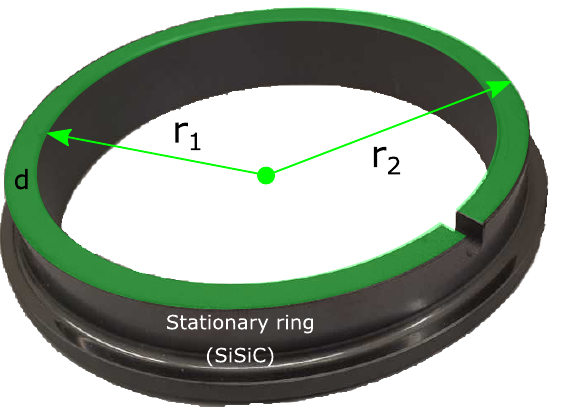
Figure 2. Schematic of the stationary ring used in this study. A transmitter has to be placed on top of the ring and inside the green area. The thickness d is given through the inner radius r 1 and the outer radius r 2 . The radial dimensions of the sensors must no be larger than the thickness d